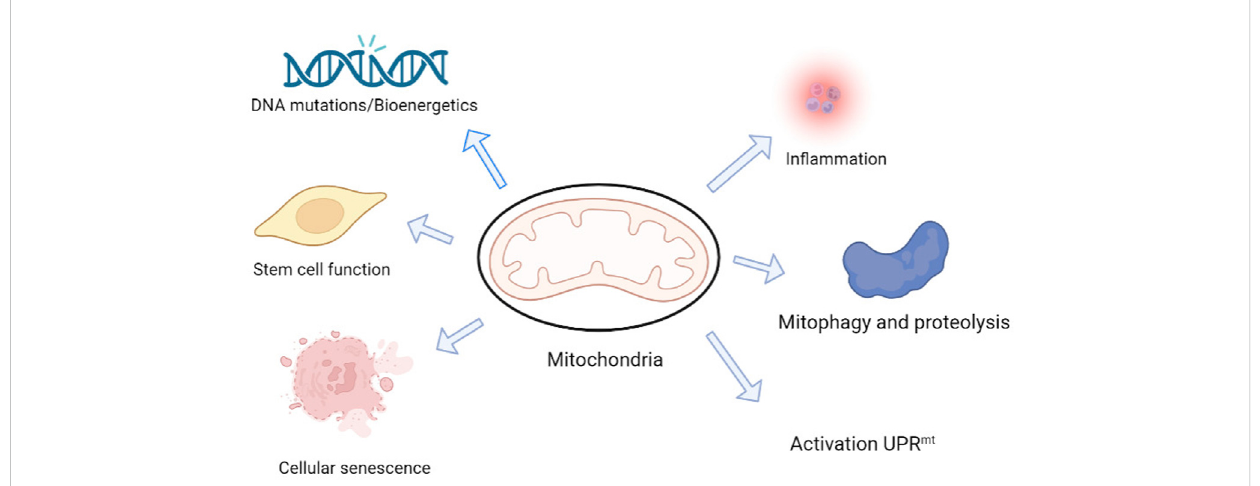
FIGURE 2 Mitochondria are possibly involved in physiological and pathological mechanisms underlying cognition changes in neurodegeneration and aging. Mitochondria are multifunctional organelles with multiple functions, from bioenergy to cell signaling, and are signaling centers that induce transcription, proteomic, and posttranslational regulation mechanisms. The mitochondria play a central role in determining the fate of neural stem cells (NSCs). Mitochondriaarealsoinvolvedinproteinassemblyandregulationandmediatecellproliferation,differentiation,anddeath.Mitochondriacaninitiate a protective program called the mitochondrial unfolded protein response (UPRmt) and use this protective mechanism to maintain normal mitochondrial function (Liu et al.,